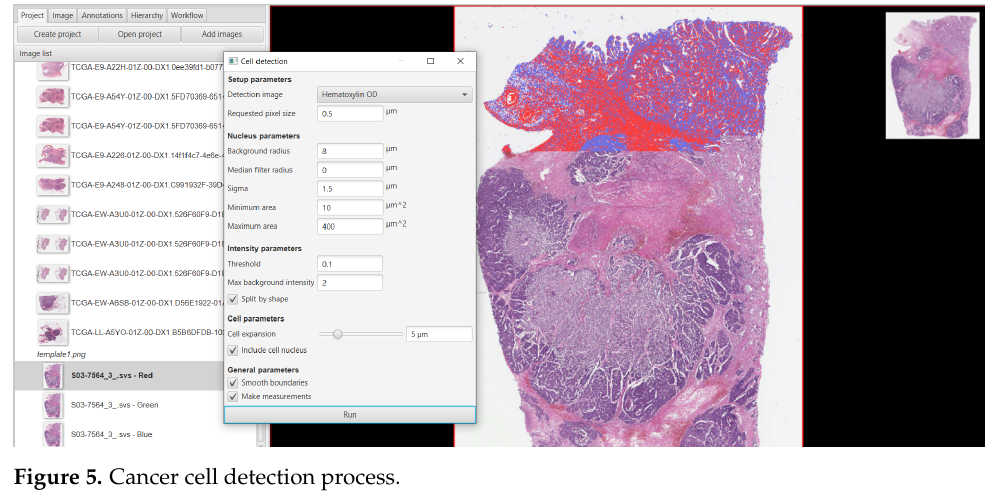
Figure 5. Cancer cell detection process.